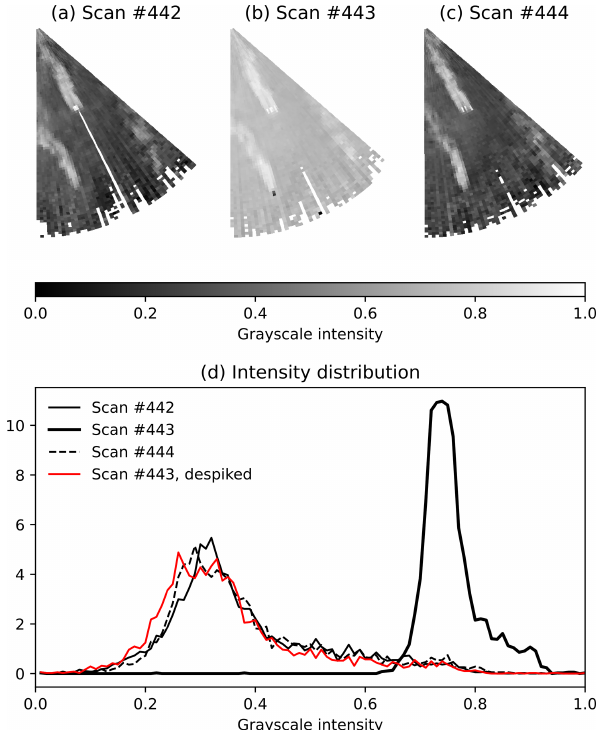
Figure 4. Consecutive lidar scans from the bimodal subset. No out- liers are present in scans 442 (a) and 444 (c) , while scan 443 (b) has wind speed spikes near the wind turbine position and in the far range; panel (d) shows the intensity distribution for the same